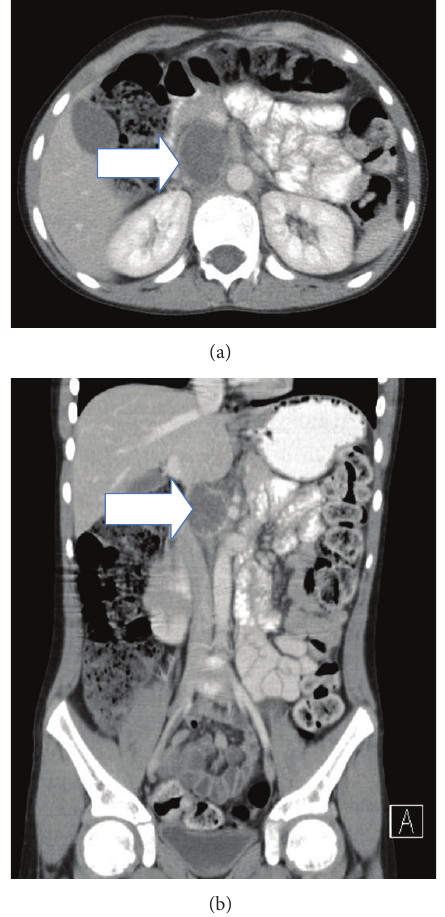
Figure 1: Axial (a) and coronal (b) images of the 3 × 2.3 cm retroperitoneal mass between aorta and inferior vena